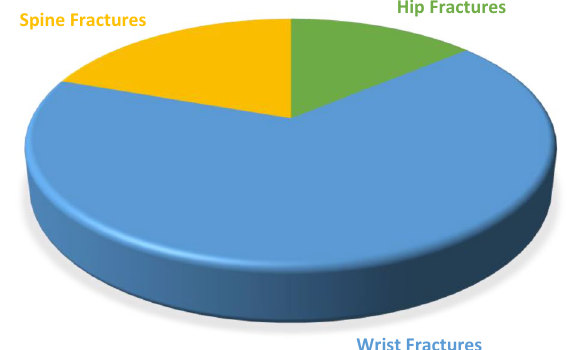
Figure 2. Pie chart figure of the overall fractures (2013–2014 and 2017–2020).